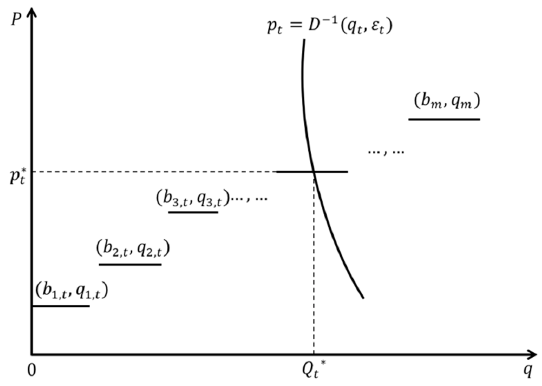
Figure 1. The bidding curves in a uniform clearing price (UCP) electricity market.